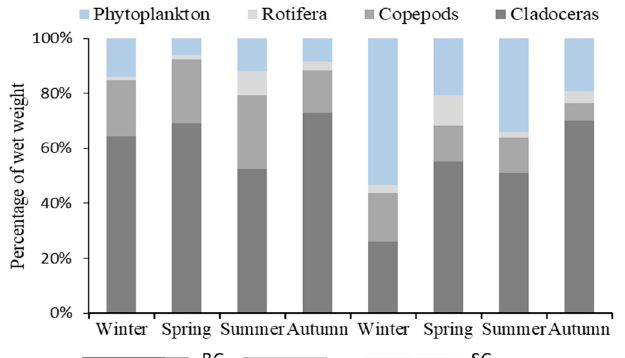
Figure 4. Seasonal variations of dietary compositions in gut contents of silver carp (SC) and bighead carp (BC).